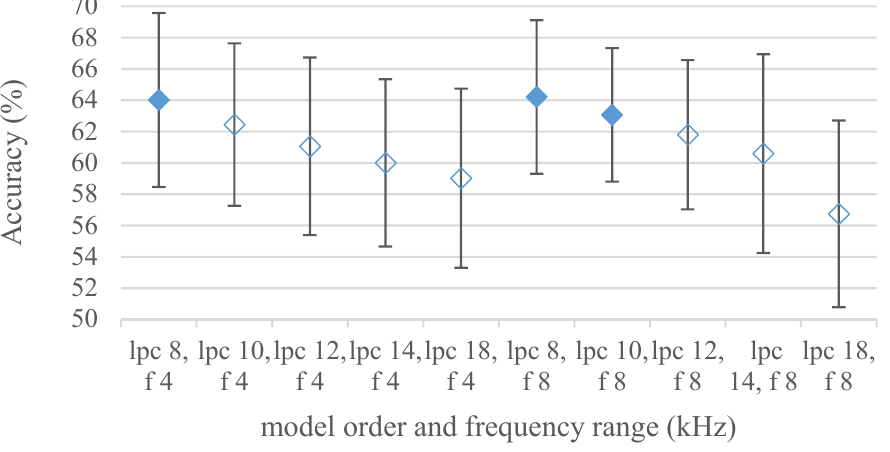
Figure 17. Averaged accuracies and standard deviations for spectrograms constructed over excitation signals with different LPC model orders (lpc){16, 18, 20}, maximal frequencies (f) {4, 8 kHz}, and pre-emphasis used to derive LPCs. Filled marks show equally performing settings.